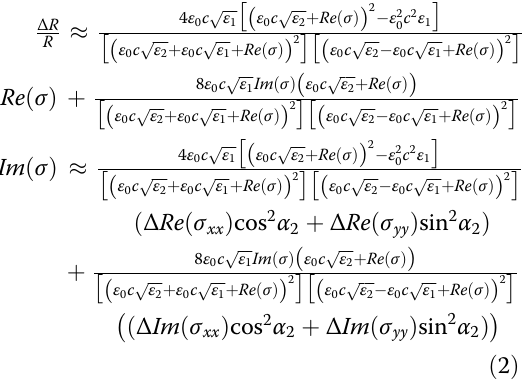
− 2 ( α 1 cos 2 pump